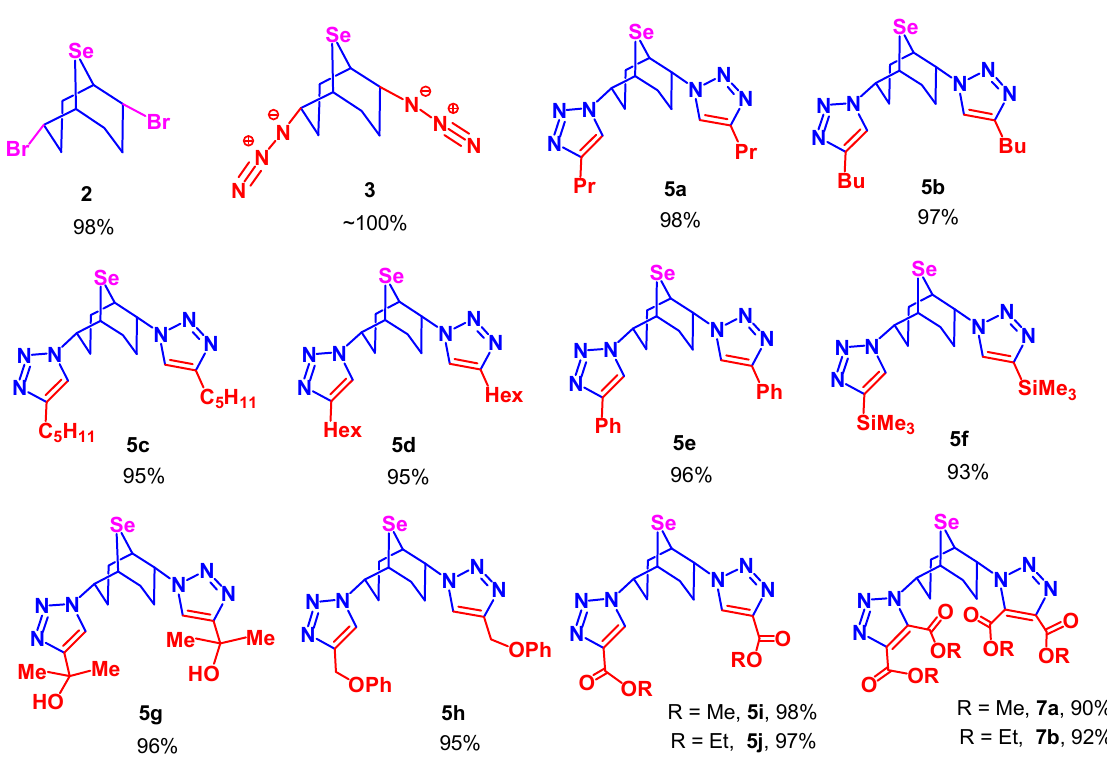
9-selenabicyclo[3.3.1]nonane 5a – j (93–98% yields) and 7a , b (90–92% yields) was developed by the cycloaddition reaction of 2,6-diazido-9-selenabicyclo[3.3.1]nonane with a variety of acetylenes (Scheme 8).